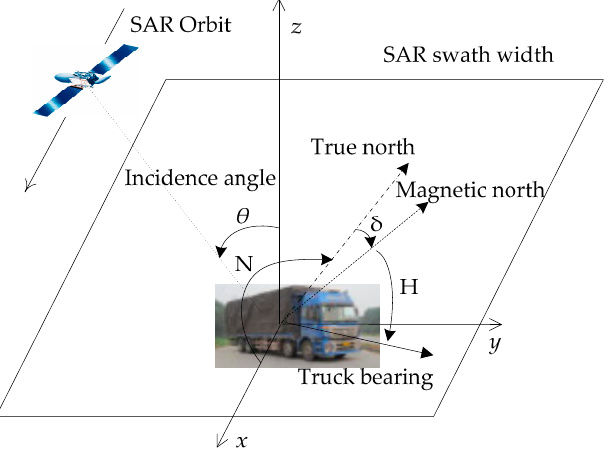
Figure 1. Measurement of aspect angle and local incidence angle at the defined Cartesian coordinates. SAR stands for Synthetic Aperture Radar.